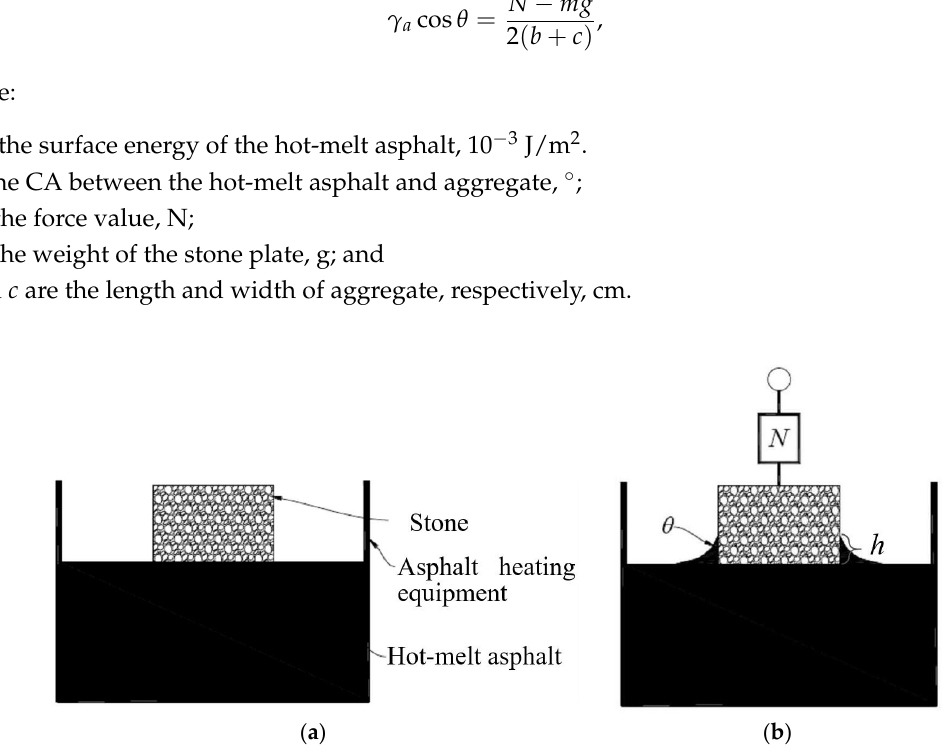
Figure 3. The hanging slice method: ( a ) Before the stone touches the liquid asphalt; ( b ) After the stone touches the liquid asphalt.